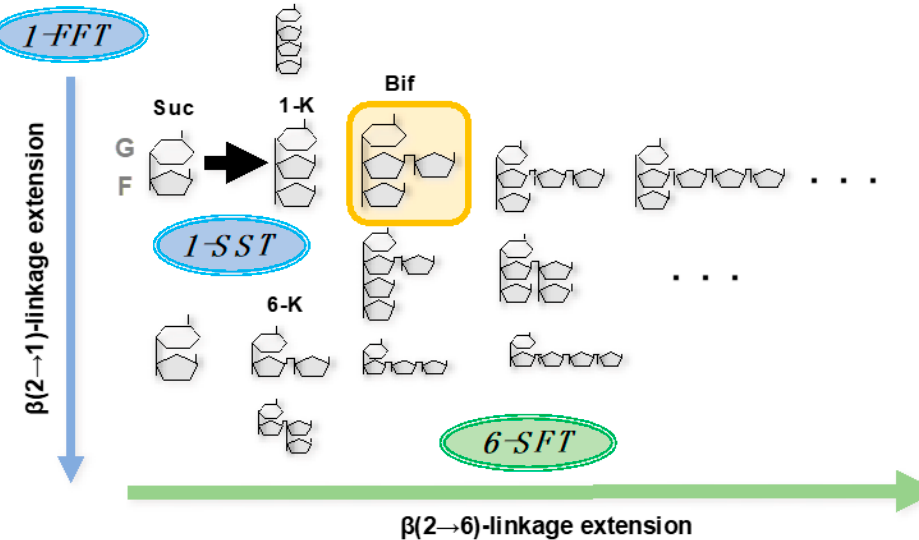
Figure 1. Illustration of fructan synthesis in wheat. G, glucose; F, fructose; Suc, sucrose; 1-K, 1-kestose; 6-K, 6-kestose; Bif, bifurcose.